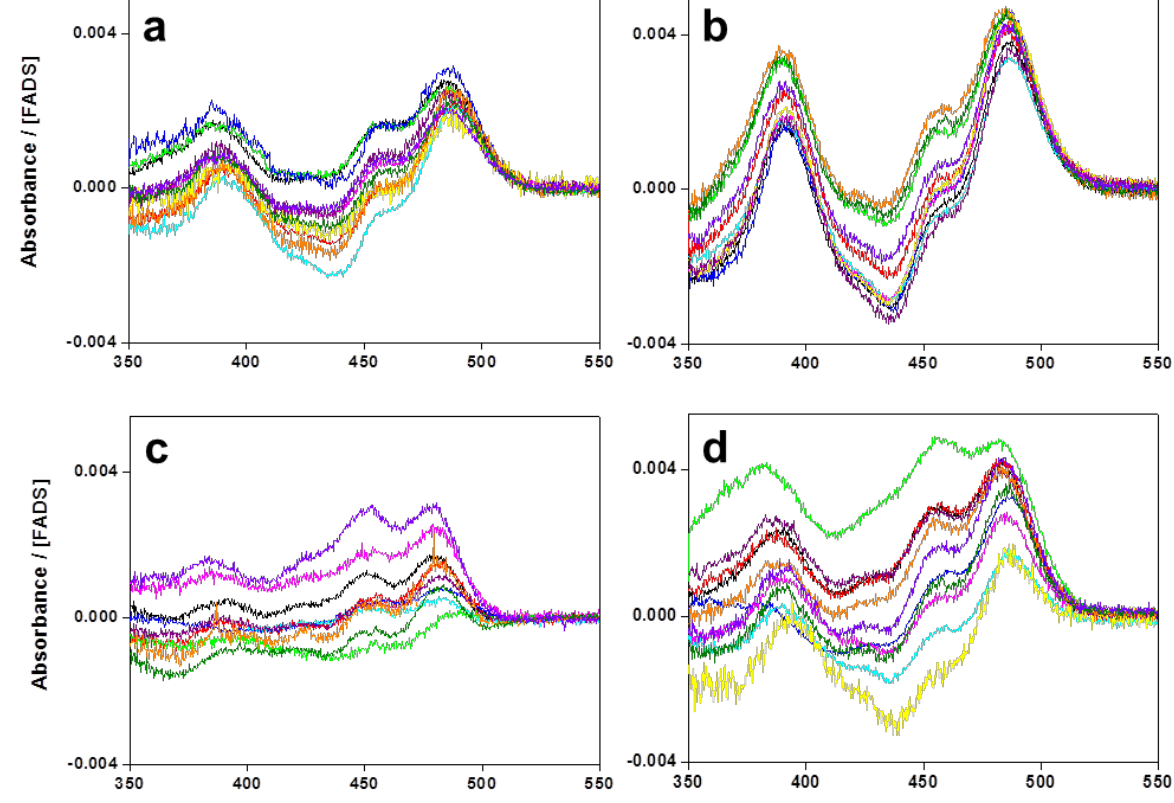
Figure S3. Visible difference spectra elicited upon addition to the Ca FADS variants (left) and their preformed Ca FADS:ADP complexes (right) of saturating concentrations of ( a and b ) RF, ( c and d ) FAD and ( e and f ) FMN for WT (black), H28D (red), H31A (green), N125A (blue), N125D (cyan), R161A (magenta), R161D (yellow), S164A (purple), S164D (orange), T165A (dark green) and T165D